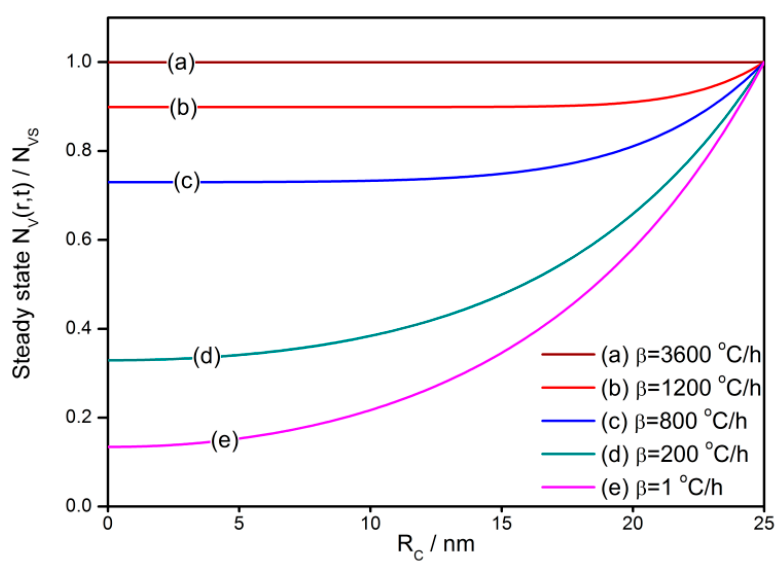
Figure 5. Influence of the cooling rate on the gradient distribution profile of oxygen vacancies in the semiconductor grain with a radius of 25 nm.